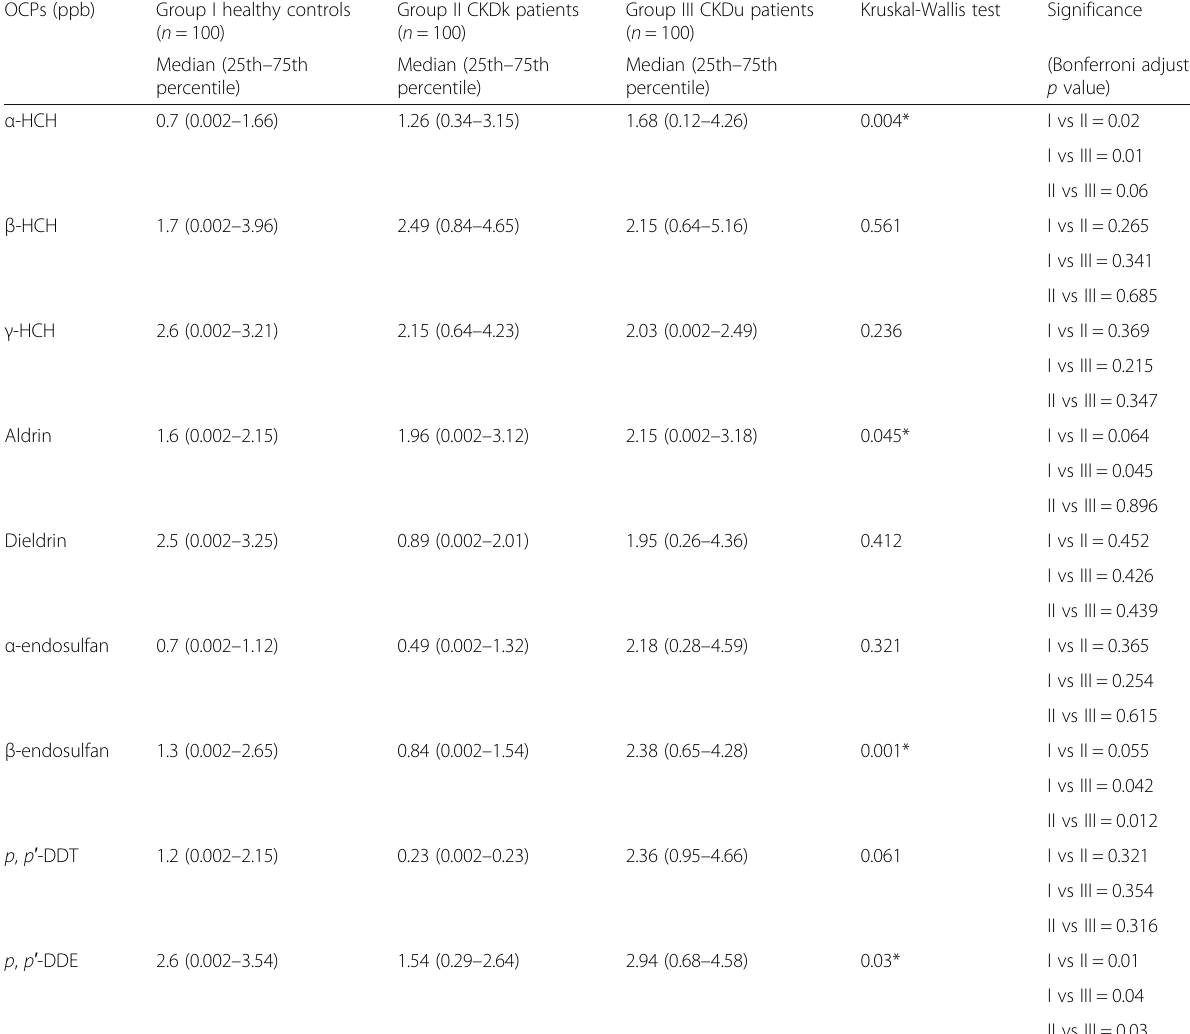
Table 2 Level of organochlorine pesticides in study subjects OCPs (ppb) Group I healthy controls ( n =